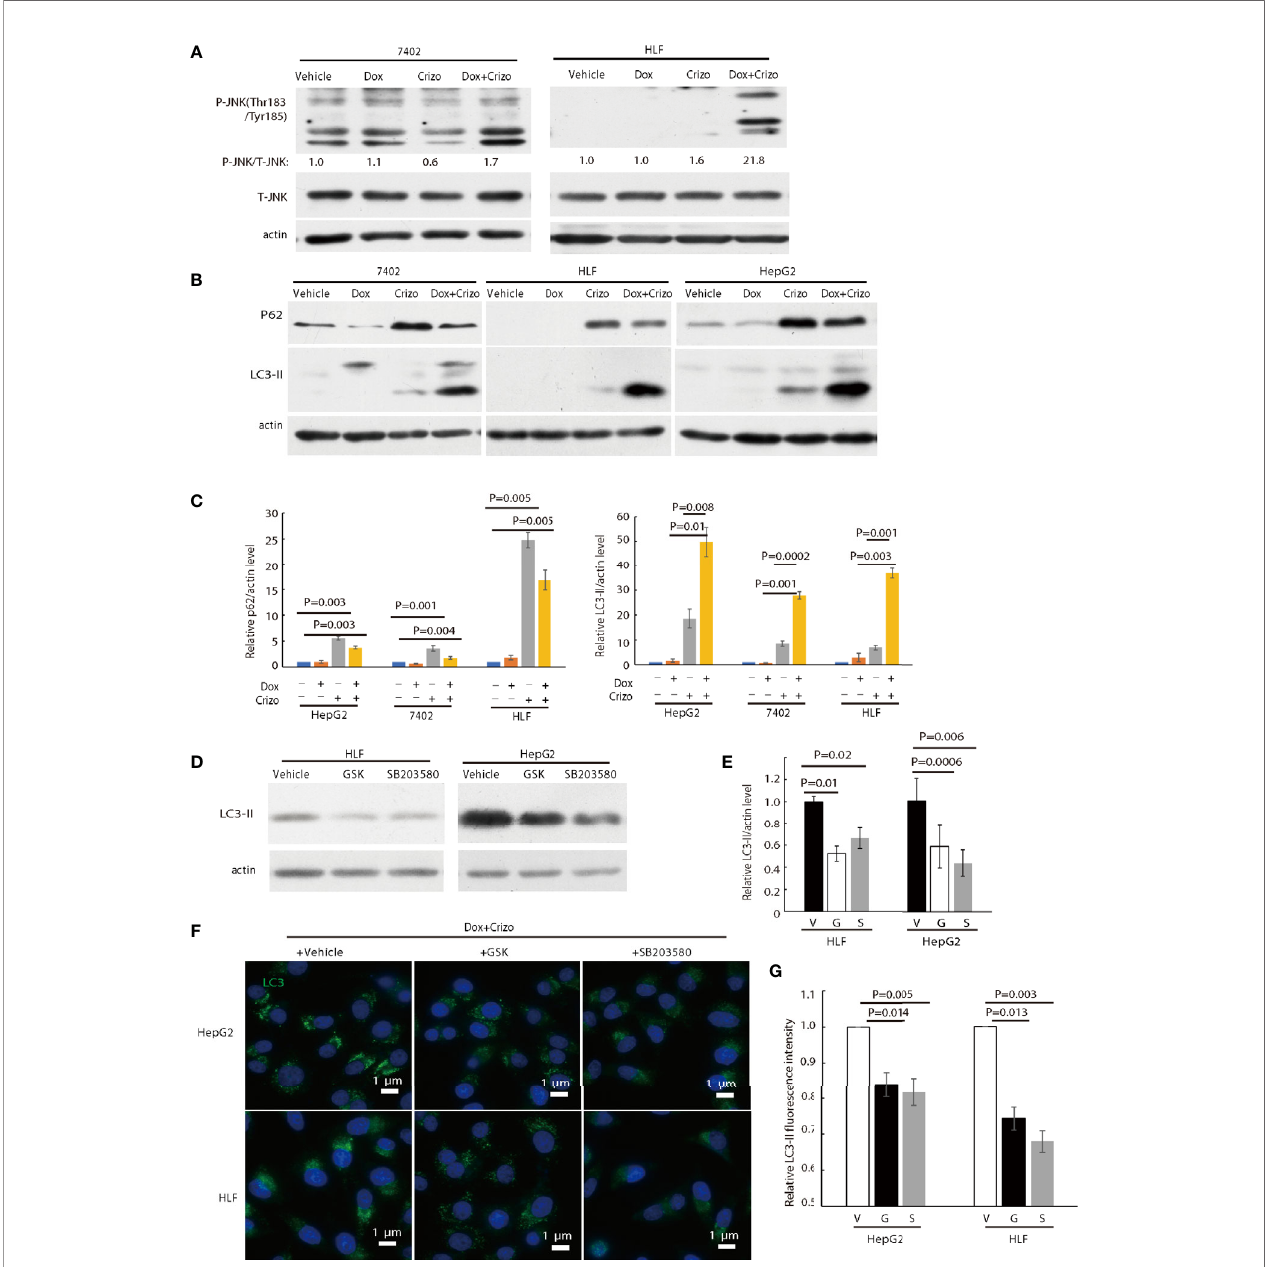
FIGURE 5 | Crizo plus Dox activate PERK-eIF2 a -JNK signaling cascade to induce autophagosome formation. (A) Cell lysates were blotted with antibodies speci fi c for JNK or phosphorylated JNK, obvious up-regulation of p-JNK was detected in cells treated with Crizo (5 m M) plus Dox (0.85 m M) but not in cells treated with vehicle, Dox (0.85 m M), or Crizo (5 m M) only. (B) Signi fi cant up-regulation of LC3-II was detected in HCC cells treated with Crizo (5 m M) plus Dox (0.85 m M) compared to that in cells treated with vehicle, Dox (0.85 m M), or Crizo (5 m M) only. Cell lysates were blotted with antibodies speci fi c to p62 or LC3, it turned out more LC3-II was observed when cells were treated with Crizo plus Dox. In addition, p62 was also up-regulated when cells were treated with Crizo plus Dox or with Crizo only. (C) Results from four experiments were analyzed. Open and fi lled in bar graph showed that mean and standard deviation of four experiments. (D) Inhibitors for PERK and JNK signi fi cantly reduced the formation of LC3-II in cells treated with Crizo (5 m M) plus Dox (0.85 m M) compared to cells treated with vehicle. Immunoblotting was performed with speci fi c antibody against LC3 for cell lysates from cells treated with Crizo plus Dox and vehicle or GSK or SB203580. (E) Results from three experiments were analyzed. Open and fi lled in bar graph showed that mean and standard deviation of three experiments. (F) GSK or SB203580 treatment of cells in the presence of Crizo (5 m M) plus Dox (0.85 m M) reduced the formation of autophagosome. Immuno fl uorescence staining of LC3 in cells treated with Crizo plus Dox and vehicle or GSK or SB203580 showed that inhibition of PERK or JNK activity mitigated the formation of autophagosome. Cells were treated with Crizo plus Dox for 22 hs and vehicle or GSK or SB203580 was added for an additional 2 hs. (G) Results from three experiments were analyzed. Open and fi lled in bar graph showed that mean and standard deviation of three experiments. Fixed cells were stained for LC3 and images were taken after nuclei counter stain. Relative immuno fl uorescence intensity or protein levels were determined with IMAGE J as speci fi ed. V, vehicle; G, GSK; SB, SB203580. P value was